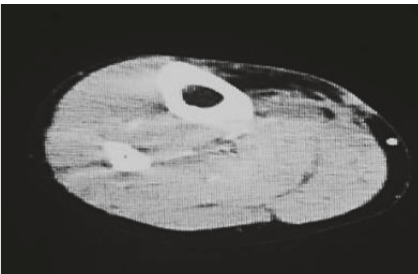
Figure 5: CT on day 100. Swelling was alleviated and disappearance of abscess was